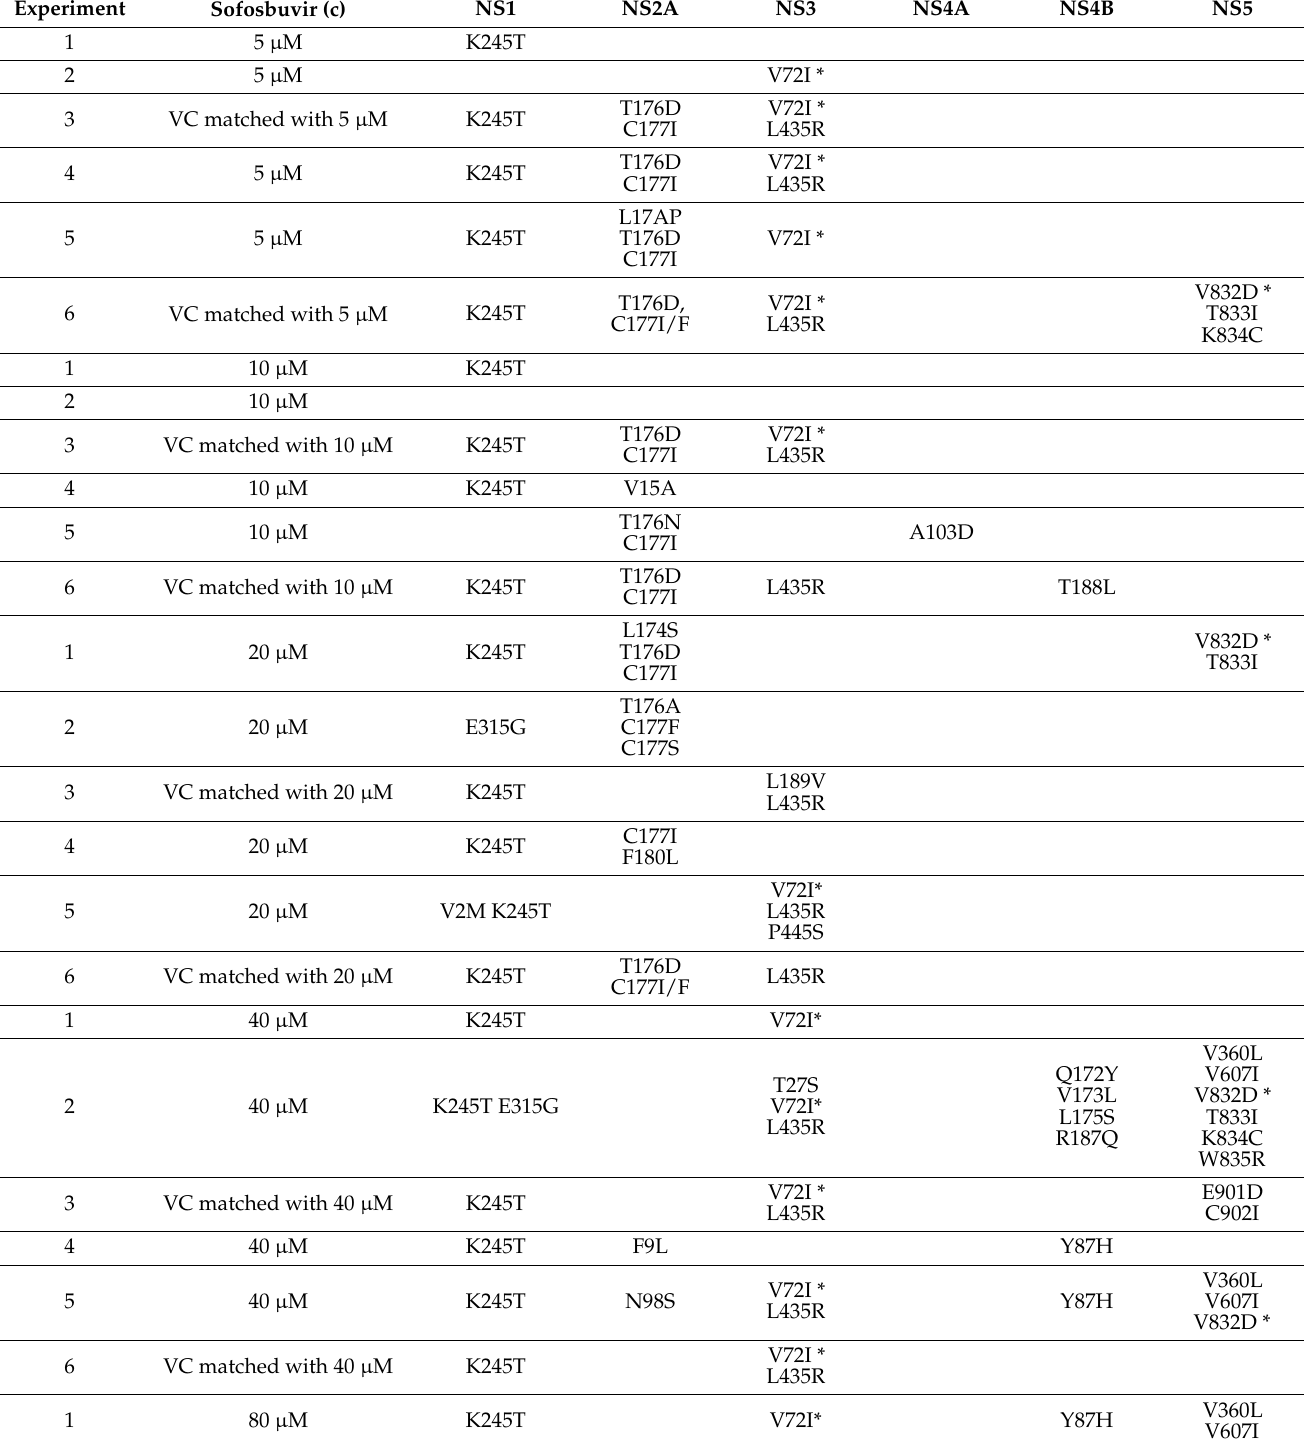
Table 2. Whole Zika virus (ZIKV) aminoacidic substitutions emerged in vitro under sofosbuvir drug pressure in NS1, NS2A, NS3, NS4A, NS4B, and NS5 genes. (c) —Drug concentration; VC—virus control.